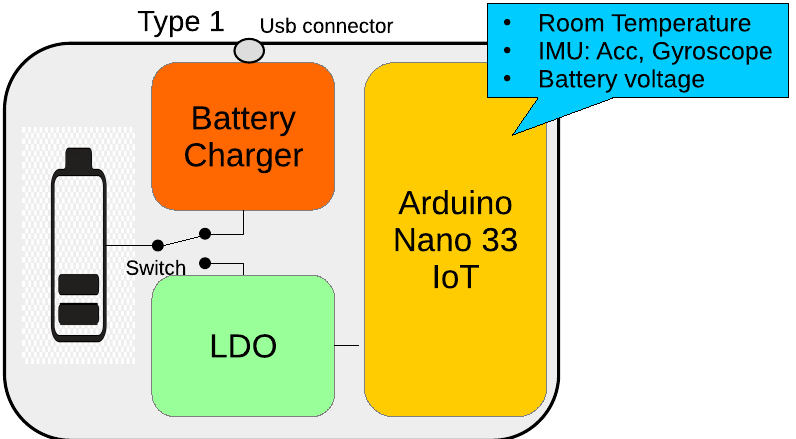
Figure 3. Block diagram of the Type 1 wearable. It contains a battery charger, LDO, battery checker, and an Arduinio Nano 33. These elements are also included in Types 2 and 3.